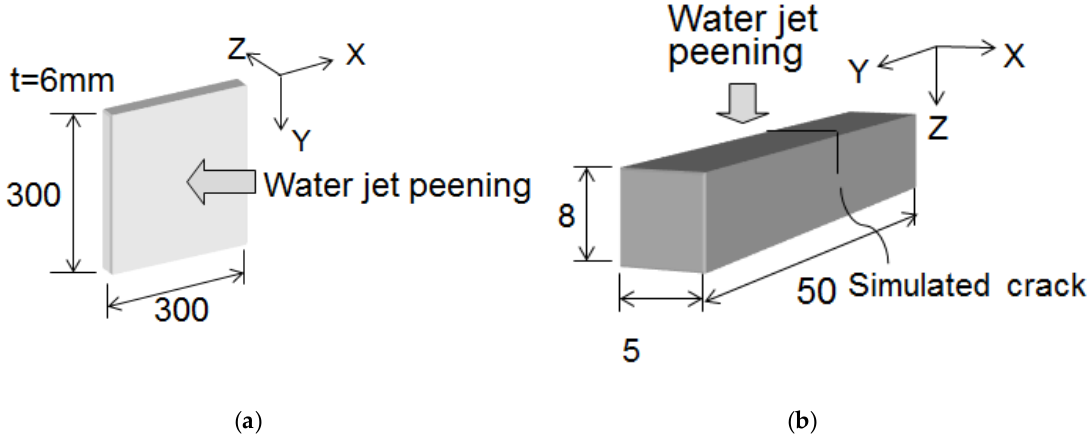
Figure 7. Shapes and dimensions of measured samples. ( a ) Plate specimen; ( b ) bar-like specimen with simulated crack.